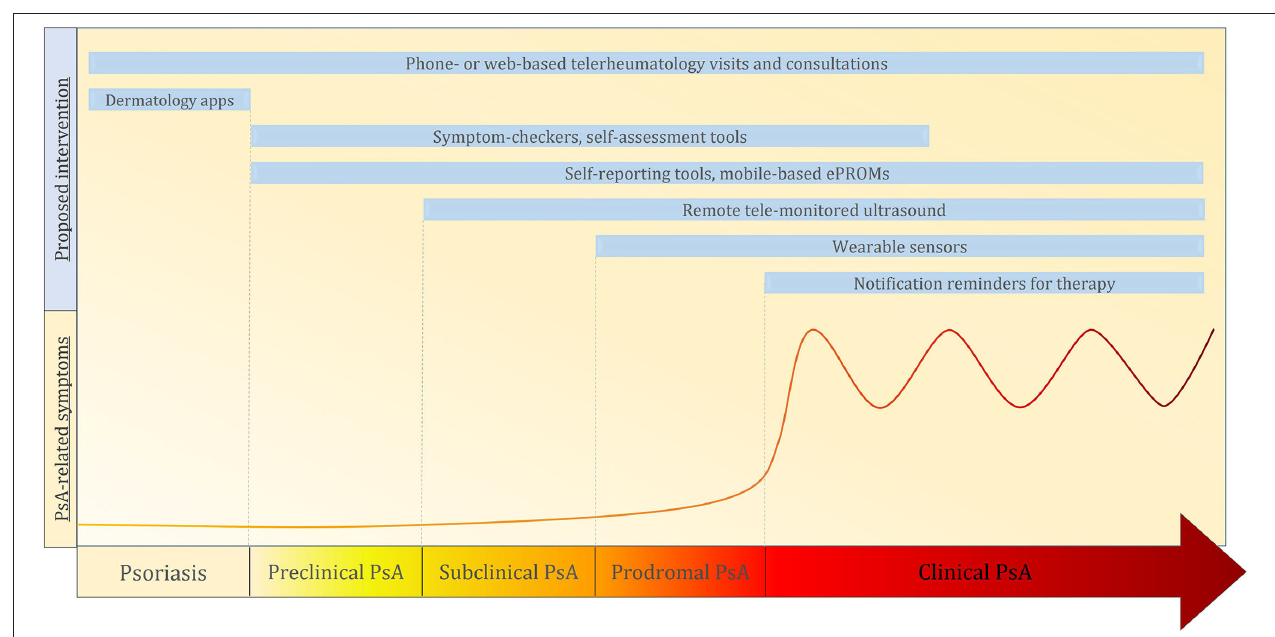
FIGURE 1 | The arrow with the yellow-red gradient represent the progression phases from psoriasis to psoriatic arthritis (from left to right). In genetically predisposed patients with psoriasis, interactions between genetic end environmental factors may lead to disease progression toward arthritis. In the preclinical phase, no clinical, serological, or imaging alterations are detectable. It is proposed that this phase is characterized by the beginning of an aberrant innate immune response in key tissues (i.e., skin, entheses, intestinal mucosa). The following subclinical phase is characterized by the presence of serum biomarkers and imaging alterations of musculoskeletal change without clinically symptomatic arthritis. This is followed by a phase of prodromal PsA in which fatigue and non-specific musculoskeletal symptoms may occur. The last stage is that of a fully blown clinically symptomatic Psoriatic Arthritis. The curve represents the burden and frequency of arthritis-related symptoms during each phase. The light blue boxes indicate the possible eHealth interventions for the management of the Psoriasis/Psoriatic arthritis progression. PsO, Psoriasis; PsA, Psoriatic Arthritis; ePROMs, electronic patient-reported outcome